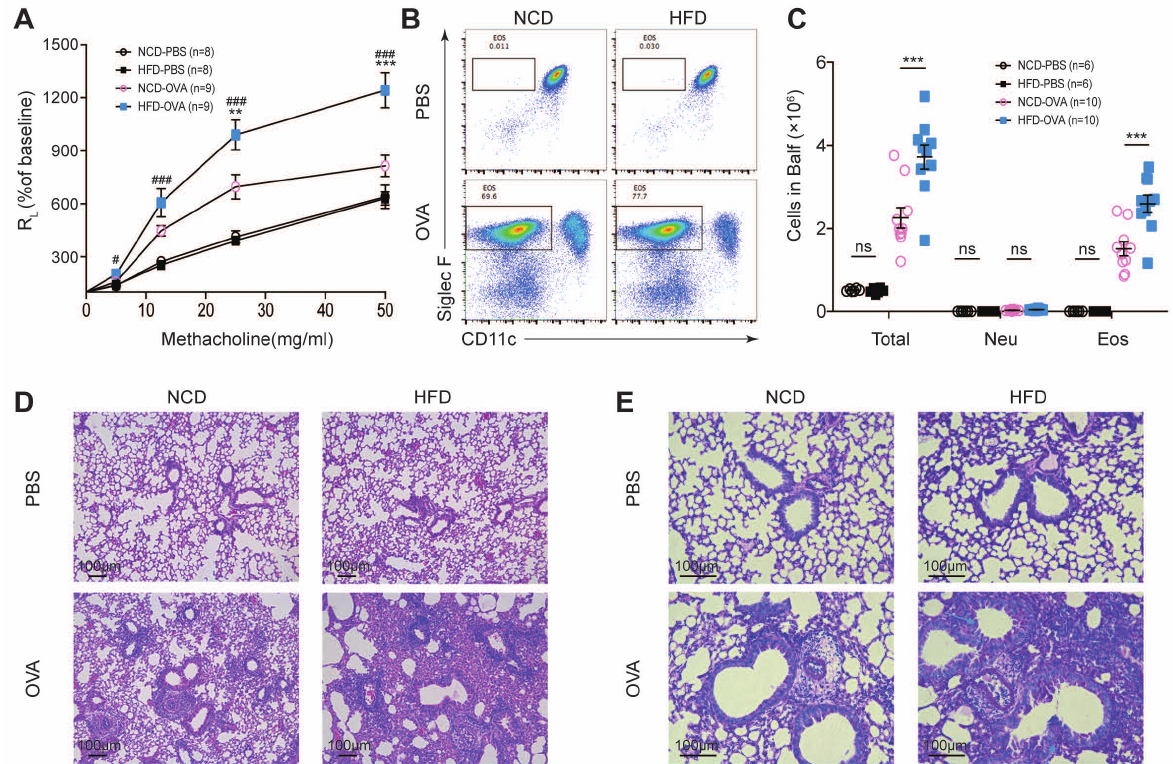
Figure 1. Maternal high-fat diet during pregnancy aggravated experimental asthma in offspring. Mice were immunized intraperitoneally and then challenged intranasally with ovalbumin (OVA) or PBS. Mice were sacrificed 24 h after the last challenge (OVA model). Offspring from breeders fed on a normal chow diet or a high-fat diet were defined as NCD or HFD throughout the study. ( A ) Airway hyperresponsiveness in terms of airway resistance (R L ), ** p < 0.01, *** p < 0.001, NCD-OVA versus HFD-OVA, and # p < 0.05, ### p < 0.001, HFD-PBS versus HFD-OVA. ( B ) Percentages of eosinophils and ( C ) quantifications of immunocytes in Bronchoalveolar lavage fluids (BALFs). Microscopy of lung sections stained with H&E ( D ) and with PAS ( E ). Scale bars represent 100 µ m. p values were determined by a one-way ANOVA with Tukey multiple comparisons p value correction ( A , C ). Each dot denotes a value acquired from a single mouse. Data are shown as means ± SEM. n , Number of mice in each group. *** p < 0.001. ns , not